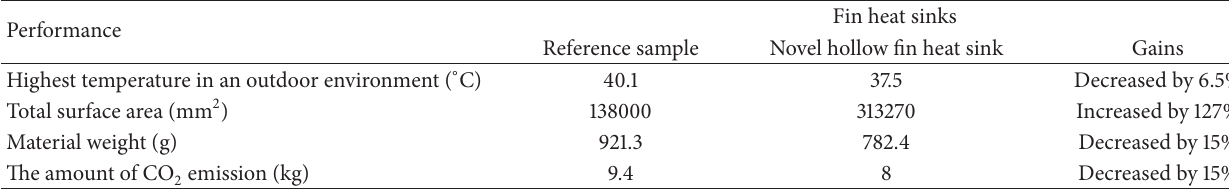
Table 2: Performance comparison between the new hollow fin heat sink and reference sample.